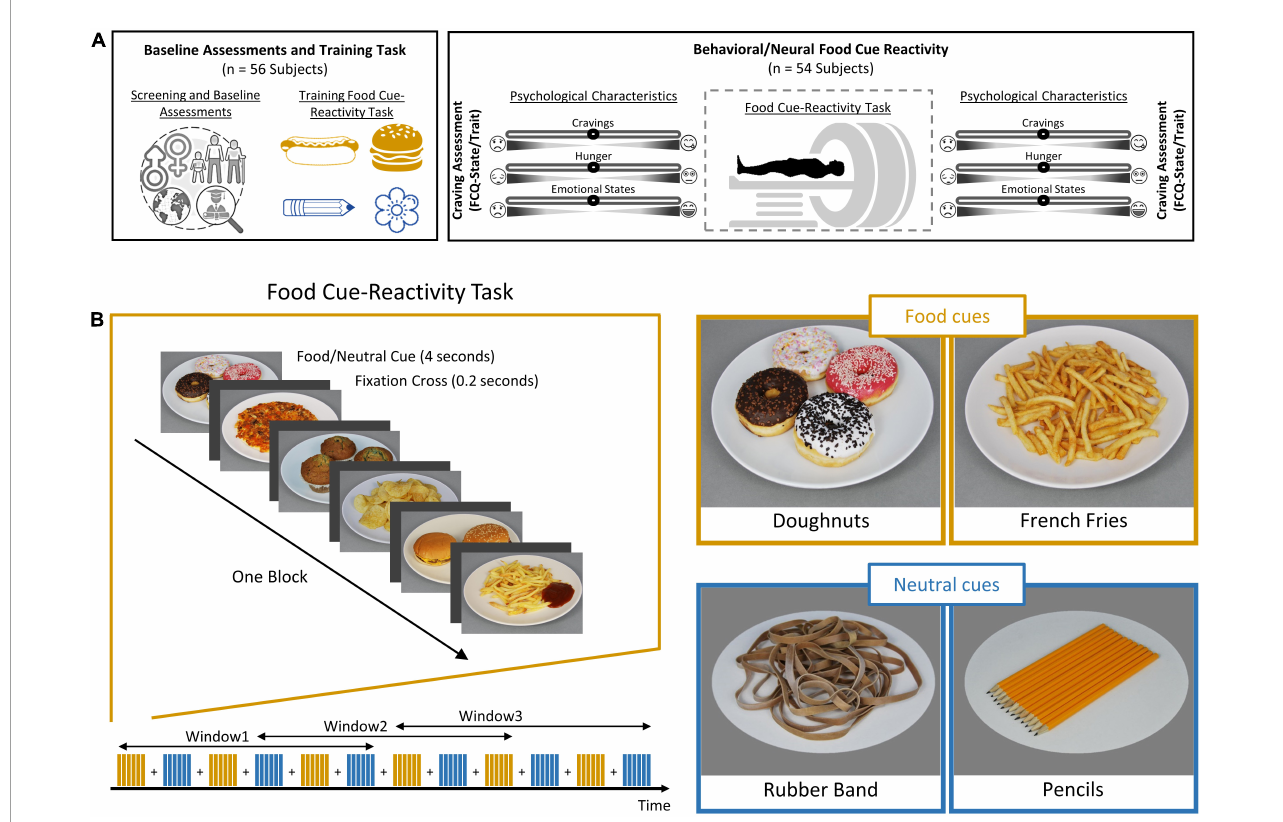
FIGURE1 Outline of study design and food cue-reactivity task. (A) Experimental procedure. Individuals were first subjected to a cognitive functional screening. Each participant ( n = 49) then underwent a food cue-reactivity training task. On the day of the experiment, participants completed the food craving questionnaire (FCQ)-state and FCQ-Trait questionnaires before undergoing an magnetic resonance (MR) scan with the food cue-reactivity task. Participants assessed their self-reported hunger, food craving, and emotional states before and after the MR scan. (B) Food cue-reactivity paradigm. In the food cue-reactivity task, participants saw 12 blocks of six pictures each (six blocks with food cues and six blocks with neutral cues). After each block, there was an inter-block interval that lasted between 8 and 12 s. Participants saw 72 stimuli throughout the course of 342